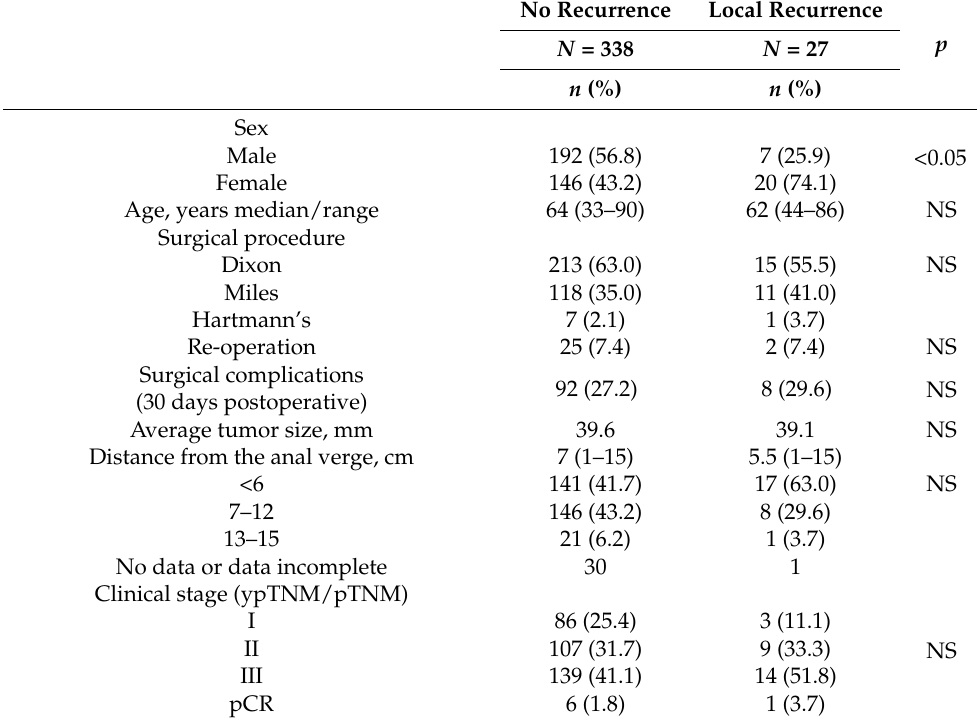
Table 1. Patient characteristics ( n =